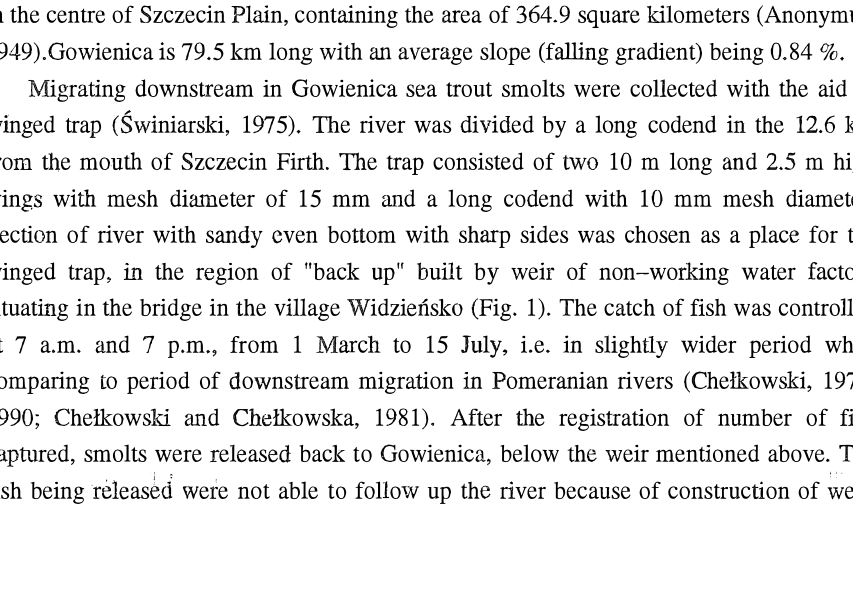
Dixon (1931) and Chrzan (1959) as well as from river Gowienica, according to Chelk:owski (1967), as ranging from 1 to 3 years, thus data on smolts of seven generations (1977-83) can be found in the work Fig. 1. Location of Gowienica river basin -·-·-·-·-State border